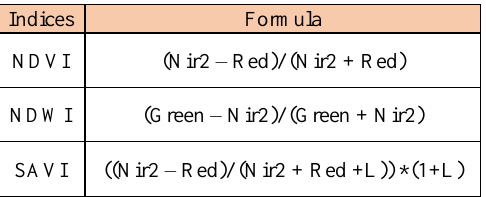
Table 2 . Indexes and related formulas.